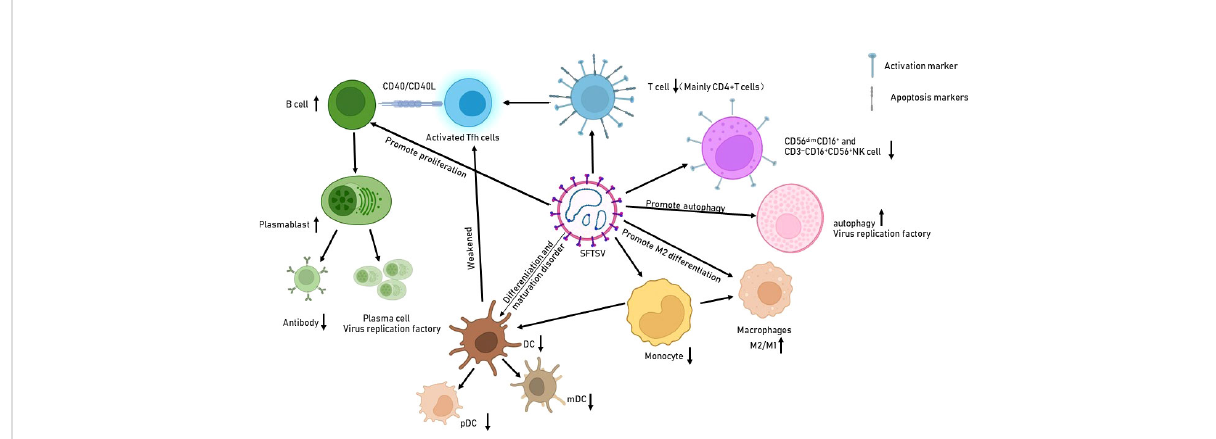
FIGURE 1 Effects of SFTSV infection on immune cells. SFTSV infection impairs the production and function of various immune cells, such as monocytes, macrophages, and DCs. It also promotes B-cell proliferation and differentiation into PBs/plasma cells, which are deemed potential virus reservoirs.